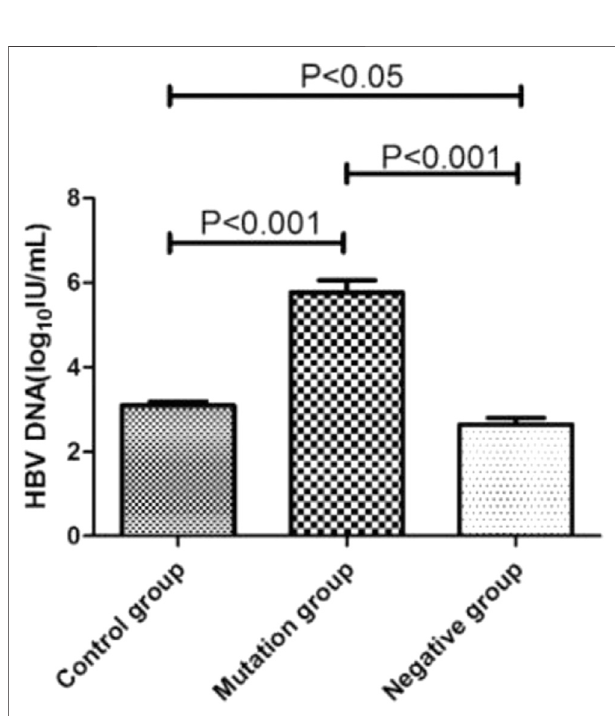
FIGURE 3 | HBV DNA level in different YMDD mutational motif and control